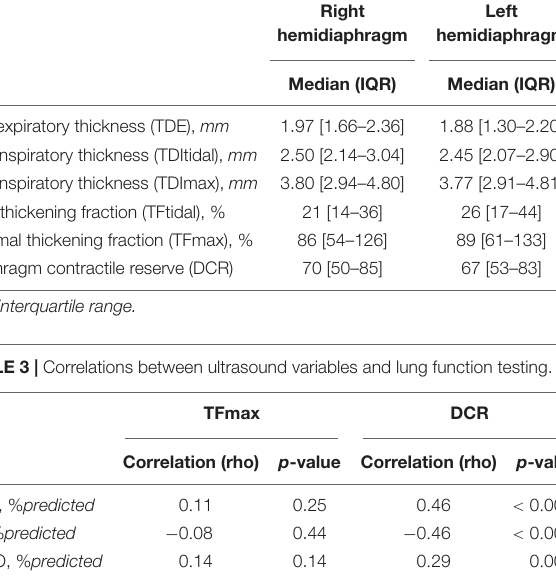
Right hemidiaphragm